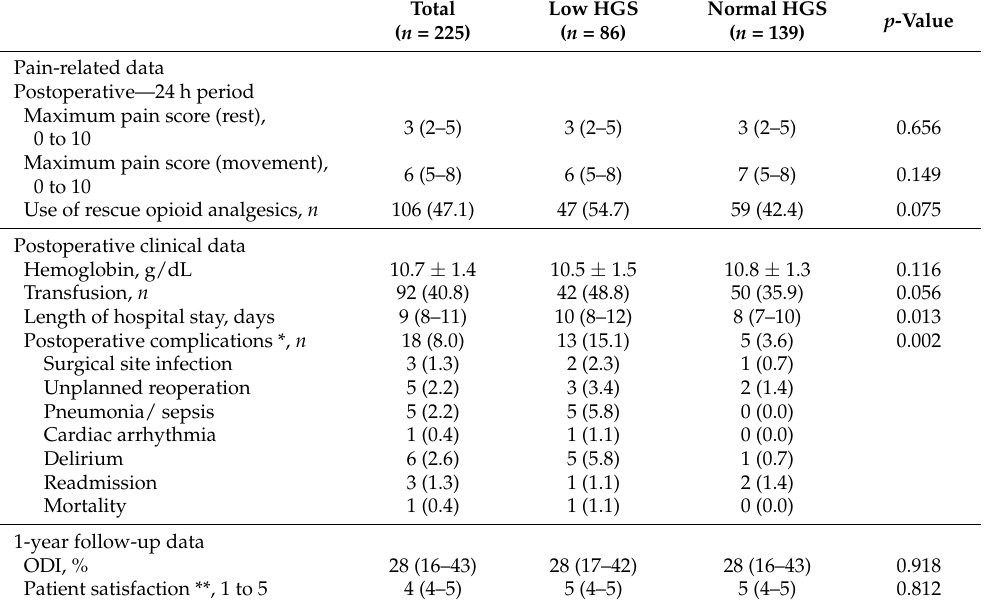
Table 3. Postoperative course.